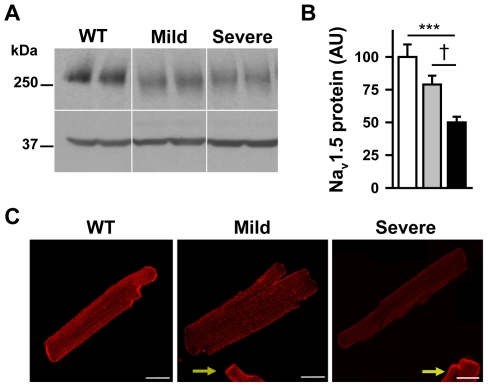
Decreased Nav1.5 expression in Scn5a
+/− mice.
A. Representative Western blots showing the expression levels of Nav1.5 in WT mice and Scn5a
+/− mice (mean age = 18±1 weeks) with a mild or a severe phenotype. Protein loading was controlled by anti-actin immunoblotting. B. Quantification of Nav1.5 expression in WT mice (open bars) and Scn5a
+/− mice with mild (grey bars) and severe (black bars) phenotype was performed on Western blots from 10 mice in each group by normalizing the intensities of the Nav1.5 bands to the actin bands. ***, p<0.001 versus WT; †, p<0.05 versus mild Scn5a
+/− mice. C. Confocal images of Nav1.5 in ventricular cardiomyocytes isolated from WT mice (left panel) and Scn5a
+/− mice with mild (middle panel) and severe (right panel) phenotype. Scale bar, 20 µm. In Scn5a
+/− images presented, a WT cardiomyocyte is also included in the image frame (yellow arrows) to illustrate the clear difference in WT versus Scn5a
+/− intercalated disc staining intensities.